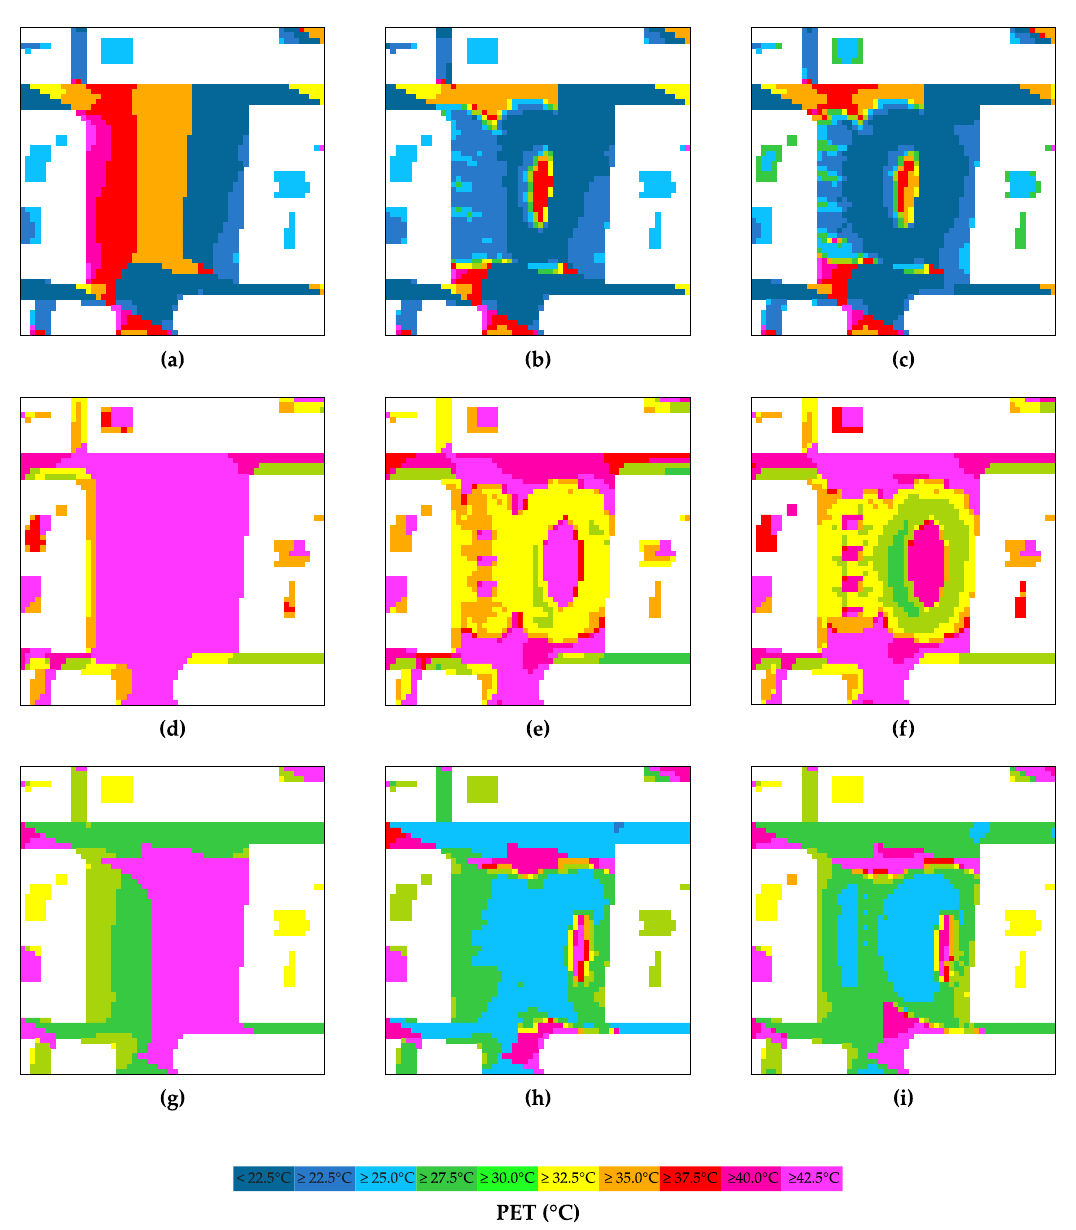
Figure 5. PET maps at 8:00, 13:00 and 17:00, on the 1st August 2014, of S0 (initial condition), S1 (cool pavements + trees) and S2 (cool roofs + cool walls + trees + grass), in detail: S0 PET at 8:00 ( a ), S1 PET at 8:00 ( b ), S2 PET at 8:00 ( c ), S0 PET at 13:00 ( d ), S1 PET at 13:00 ( e ), S2 PET at 13:00 ( f ), S0 PET at 17:00 ( g ), S1 PET at 17:00 ( h ), S2 PET at 17:00 ( i ). At 8:00, PET values for scenario S0 (a) range from a minimum value below 22.5 °C in the SE area of the square, shaded by the surrounding buildings, to a maximum value above 42.5 °C alongside the western façades of the square, which receives direct solar radiation. Whereas, the central area of the square presents a uniform distribution of PET values, between 35 °C and 37.5 °C. For scenario S1, PET values (b) are consistently lower throughout the square, not only in the shaded areas near the buildings, but also in the areas corresponding to the cool pavements and trees. A limited area on the SW angle of the square and the central area not shaded by trees exhibit PET above 37.5 °C, while the minimum value below 22.5 °C is located in the same SE area of scenario S0, affected by buildings’ shading patterns, and in the central area underneath the Koelreuteria paniculata trees. On NW, under the other trees, Citrus x aurantium and Albizia julibrissin , characterized by with a smaller crown (LAD respectively of 0.55 m 2 /m 3 and 0.65 m 2 /m 3 ), PET is comprised between 22.5 °C and 25.0 °C. Scenario